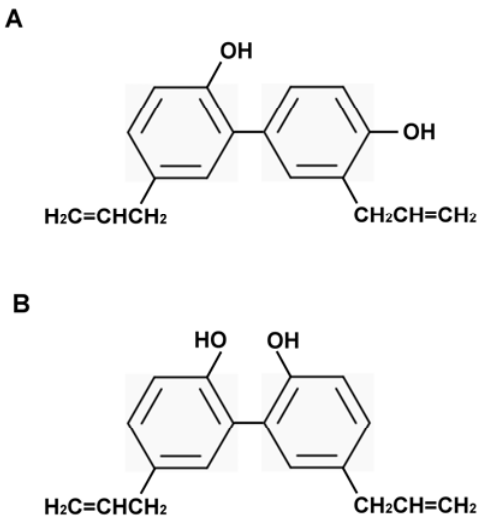
Figure 1. The chemical structures of (A) honokiol and (B)